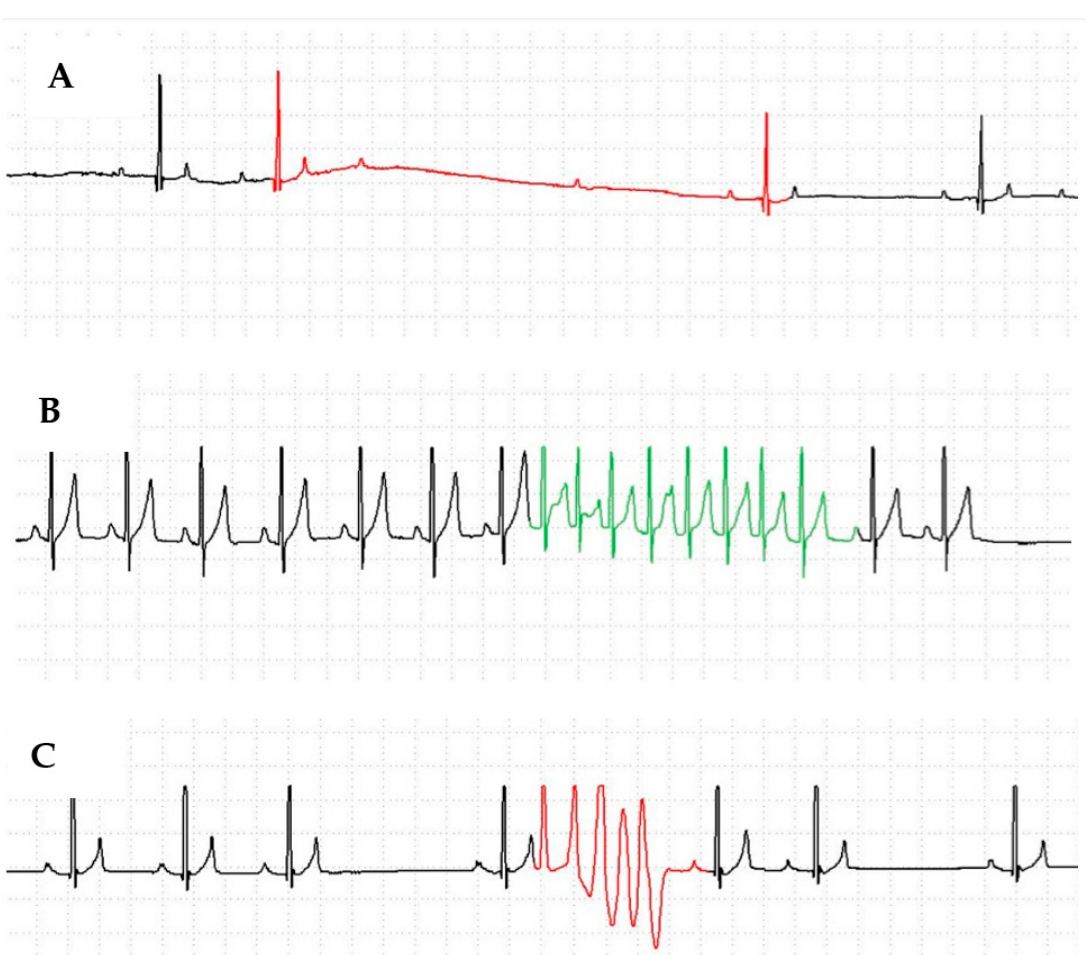
Figure 1. Affected Rhodesian Ridgebacks were observed to have three different cardiac arrhythmias. ( A ) Second degree atrioventricular block. ( B ) Sinus rhythm with supraventricular tachycardia. ( C ) Sinus rhythm with ventricular premature complexes.